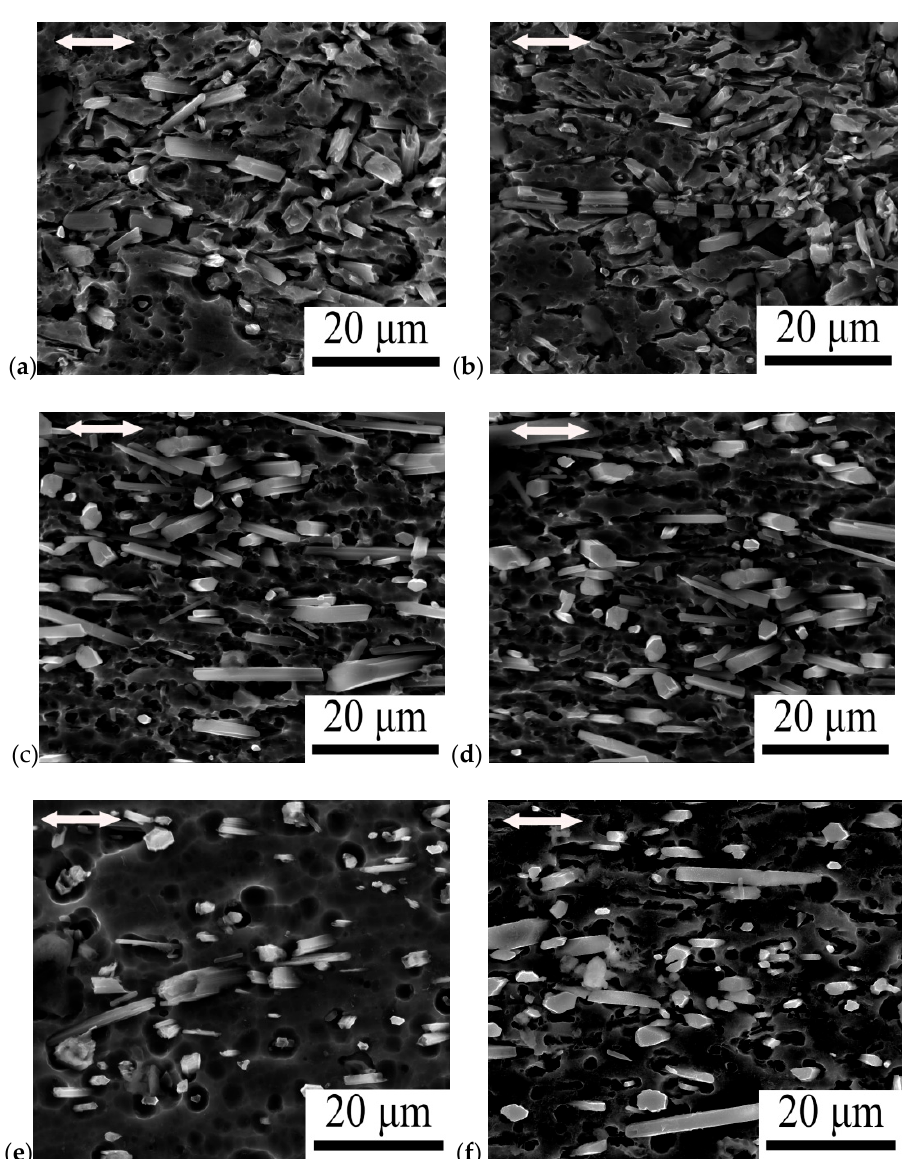
Figure 4. SEM microstructure of the Ti-15Mo/TiB TMC produced using spark plasma sintering (SPS) at 1400 ◦ C; uniaxial compression at a nominal strain rate of 10 − 3 s − 1 and temperatures ( a ) 500 ◦ C, ( b ) 600 ◦ C, ( c ) 700 ◦ C, ( d ) 800 ◦ C, ( e ) 900 ◦ C, and ( f ) 1000 ◦ C. The compression axis is vertical in all cases and the metal flow direction is shown by arrows.